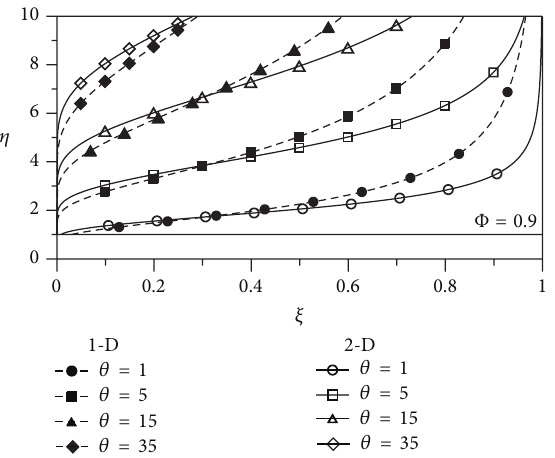
Figure 3: Optimum profiles of metal content at Φ = 0.9 , 𝑔(𝜂) = 𝜂 2 .